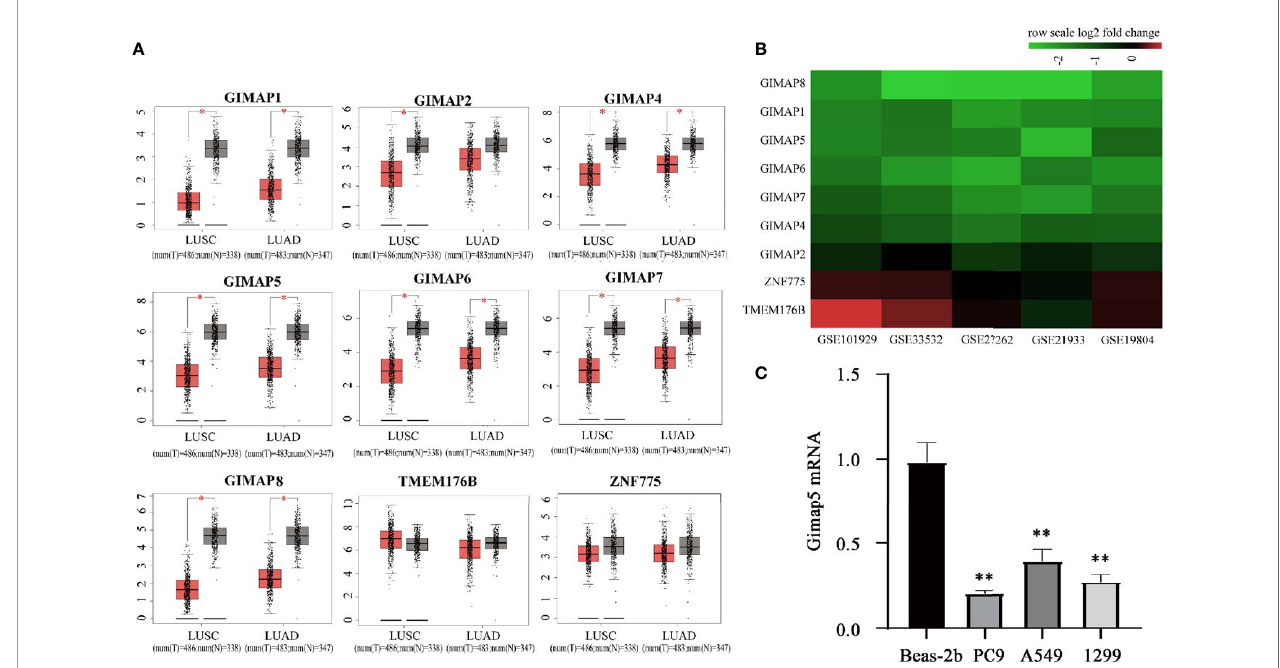
FIGURE 1 | GIMAP family expression were downregulated in lung cancer. (A) GEPIA boxed plots of GIMAP family in human LUSC, LUAD and normal lungs from TCGA. Transverse axis represents different lung cancer types, LUSC and LUAD and longitudinal axis represents a multiple of the difference in GIMAP gene expression between cancer tissue and normal tissue, and red for lung cancer tissue, gray for normal tissue. * p < 0.01 (LUSC: tumor = 486, normal = 338; LUAD: tumor = 483, normal = 347). (B) The GIMAP family gene was signi fi cantly down-regulated in fi ve data sets (abscissa axis), but there were no changes in TMEM176B and ZNF775 adjacent to the family genes (axis of ordinates), red represents up-regulation, green represents down-regulation. The darker the color, the more obvious the difference in expression. (C) Gimap5 expression in various lung cancer cell line or human bronchial epithelial cells (n = 3). ** p < 0.01 vs . Beas-2b